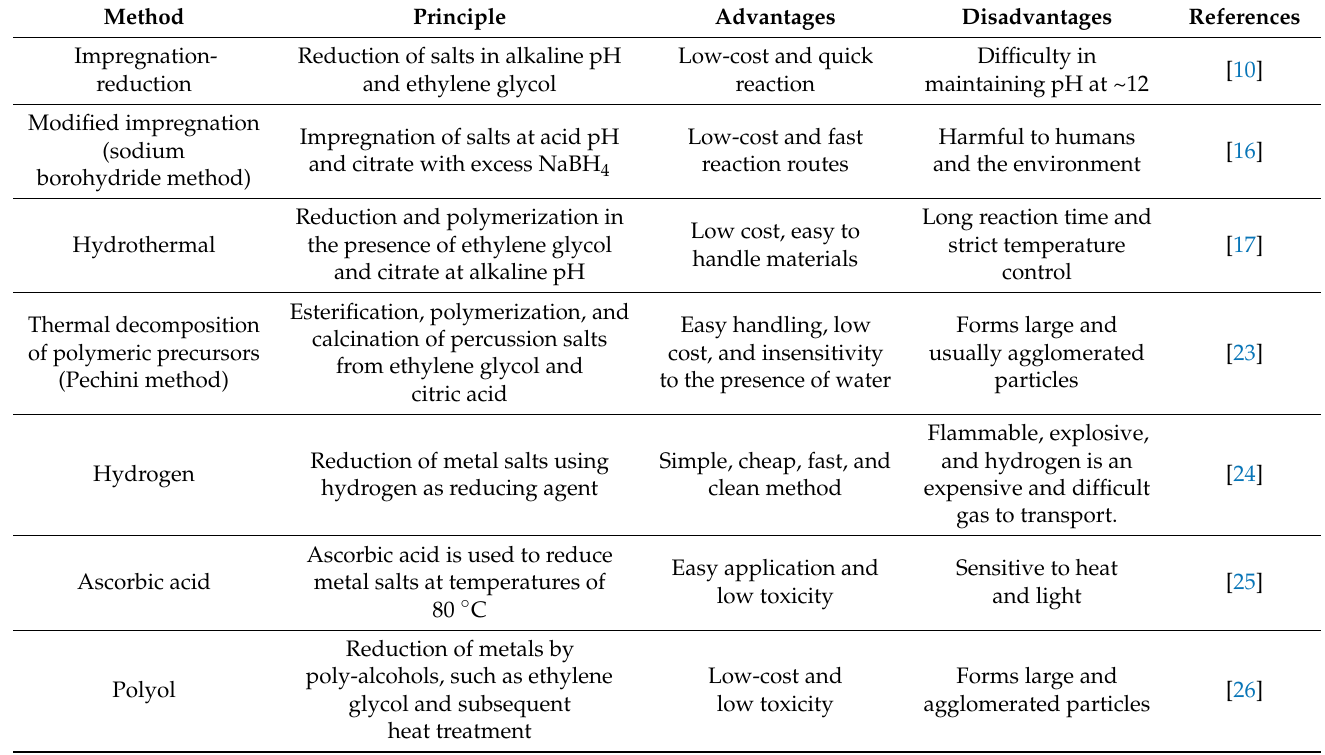
Table 1. Main synthesis methods for Pd-based